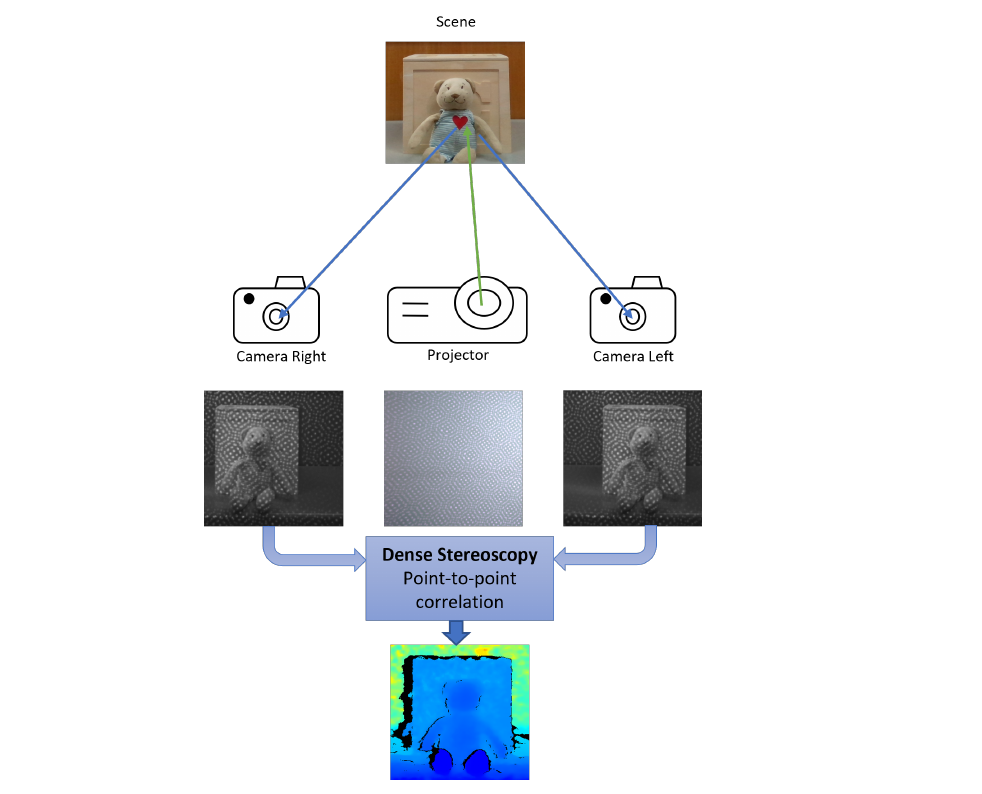
Figure 4. An illustration of an Active Stereoscopy sensor: The projector emits one random pattern onto the scene. This pattern adds additional features, thus, more correspondences. The scene depth is then estimated by triangulation using the disparity